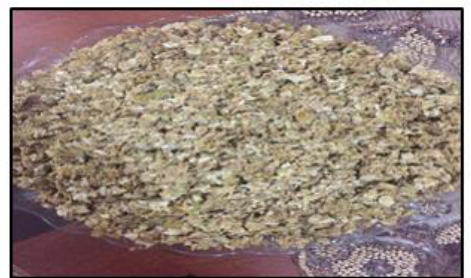
Fig. 2: Preparation natural papers (citrus aurantium).